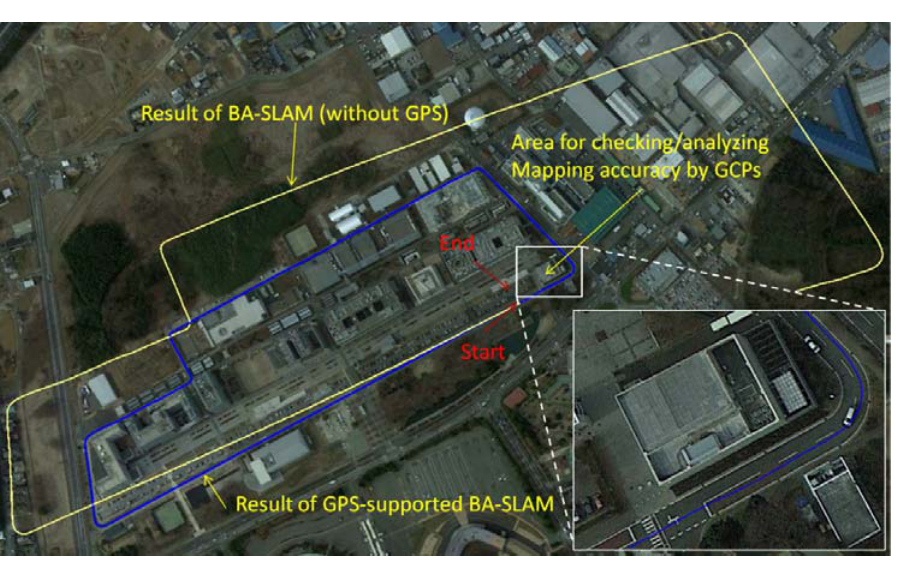
Figure 6. Results of the segmented BA-SLAM and GPS-supported BA-SLAM methods. The yellow line is the trajectory of the unconstrained results after data association and block BA. The start point is located in the correct position, but the trajectory shows a large accumulation of uncertainty in angle and scale. The blue line represents the trajectory after the GPS-supported BA-SLAM method is applied and shows a high level of accuracy. All eight GCPs are located in the enlarged area and are shown in Figure